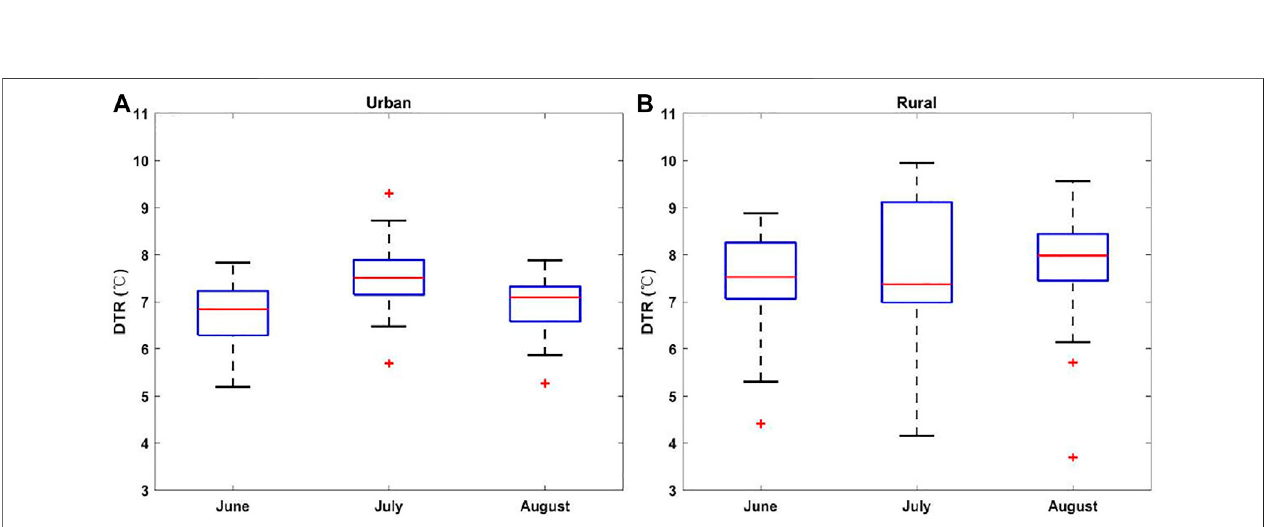
FIGURE 6 | Boxplots of the DTR of (A) urban and (B) rural stations in the urban agglomeration of the Yangtze River Delta region from June to August.